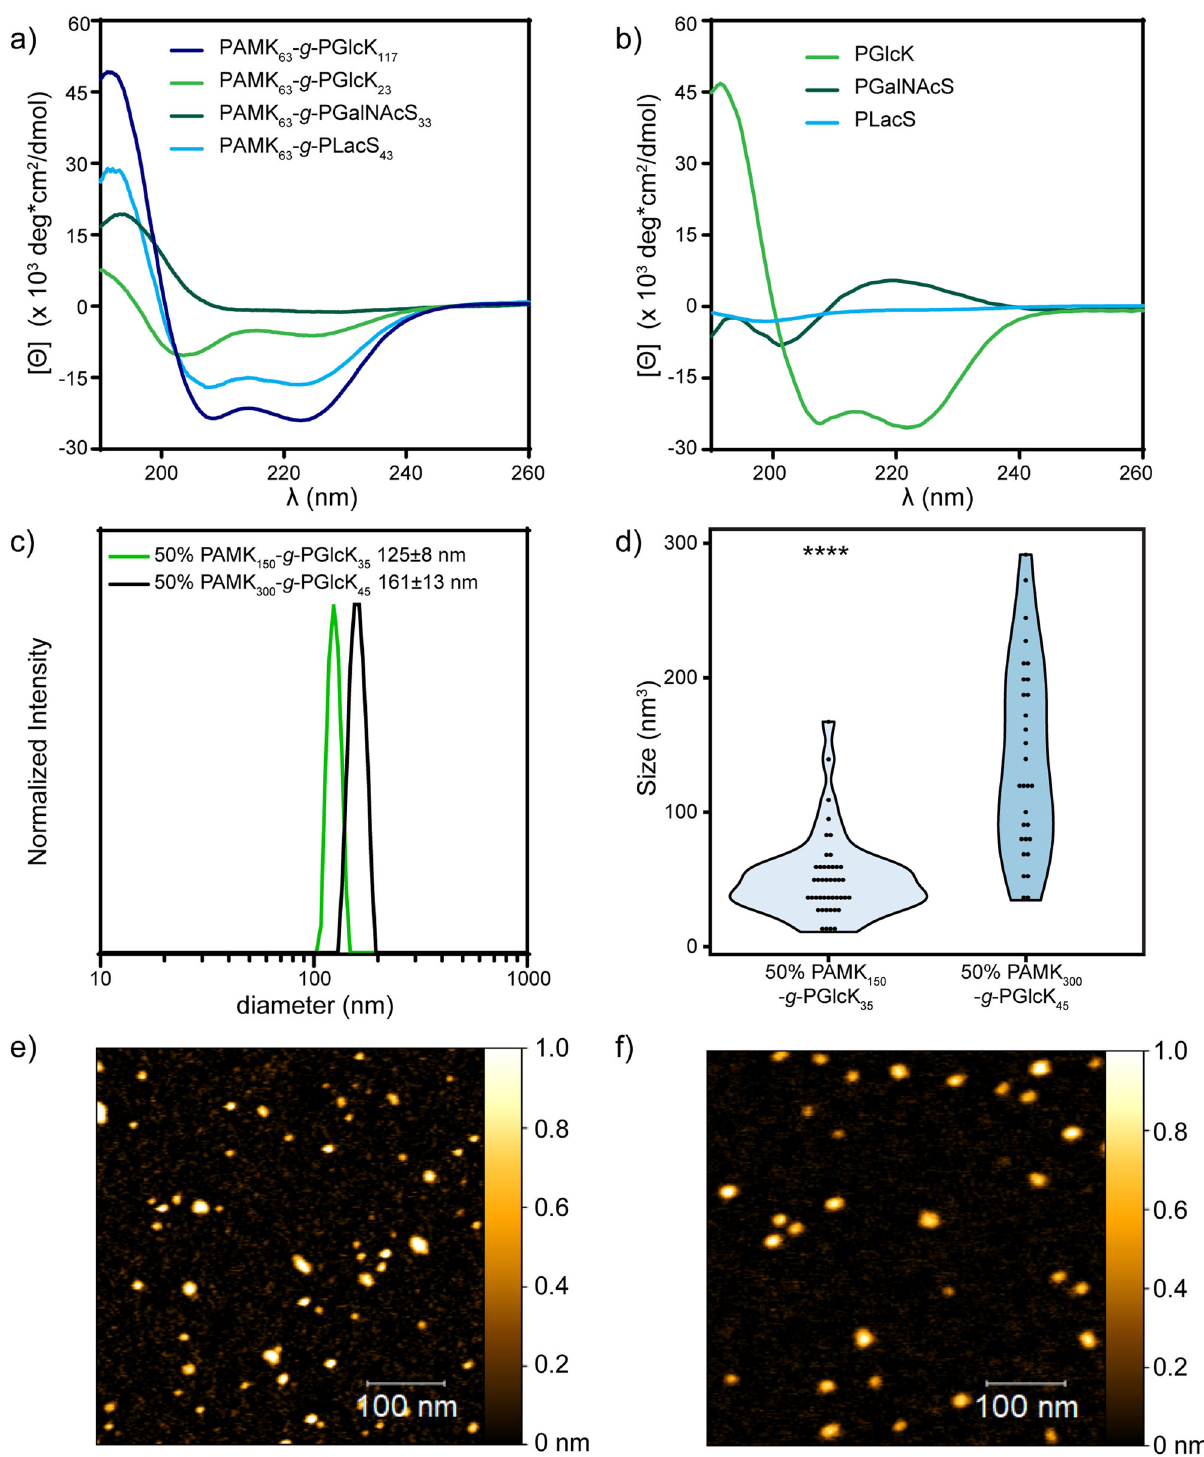
Fig. 3 Analyses of glycobrush conformations and morphologies. a CD spectra of various glycobrushes. b CD spectra of linear glycopolypeptide branches. c Hydrodynamic size distribution determined via DLS. d Glycobrush particle volume analysis from AFM images. **** P -value < 0.0001 from a two-sided Mann – Whitney test. n = 30 for (PAMK 0.5 - s -PEG 2 K 0.5 ) 300 -g-PGlcK45 and n = 44 for (PAMK 0.5 - s -PEG 2 K 0.5 ) 150 -g-PGlcK 45 . e AFM image of (PAMK 0.5 - s